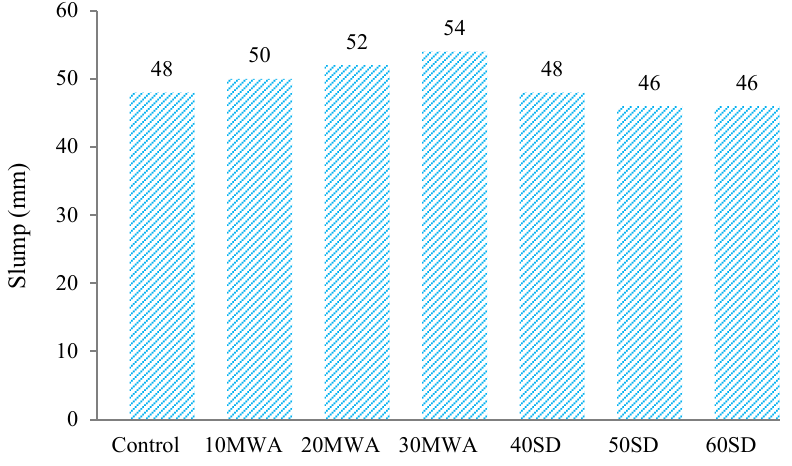
Figure 3. Slump values for MWA and SD based concrete.